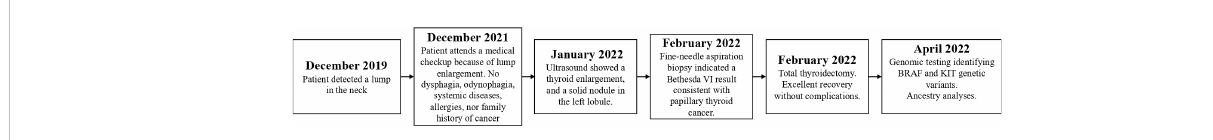
FIGURE 1 Subject ’ s relevant episodes of care. The disease-associated episodes of care are presented in the fi gure.